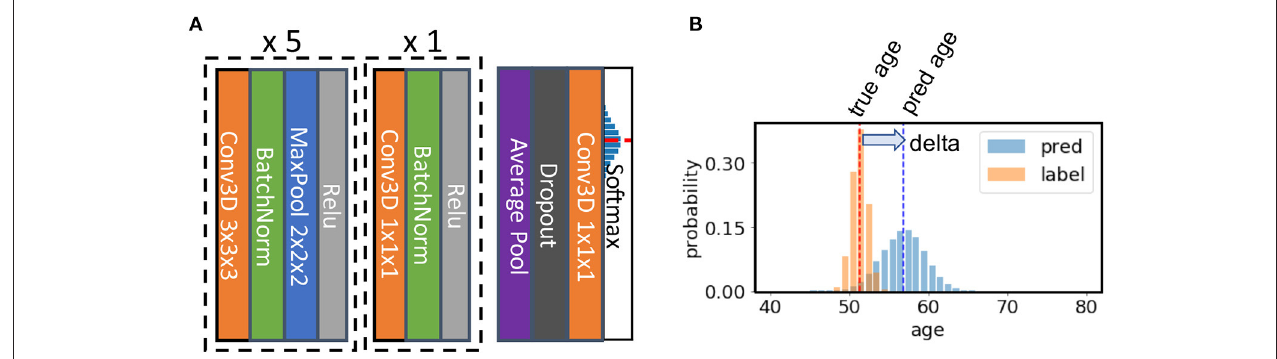
FIGURE 2 | Illustration of the core network for the Simple Fully Convolutional Neural Network (SFCN) model. (A) SFCN model architecture. (B) An example of soft labels and output probabilities. The figure is reproduced from Peng et al. (24) under CC-BY-NCND 4.0.